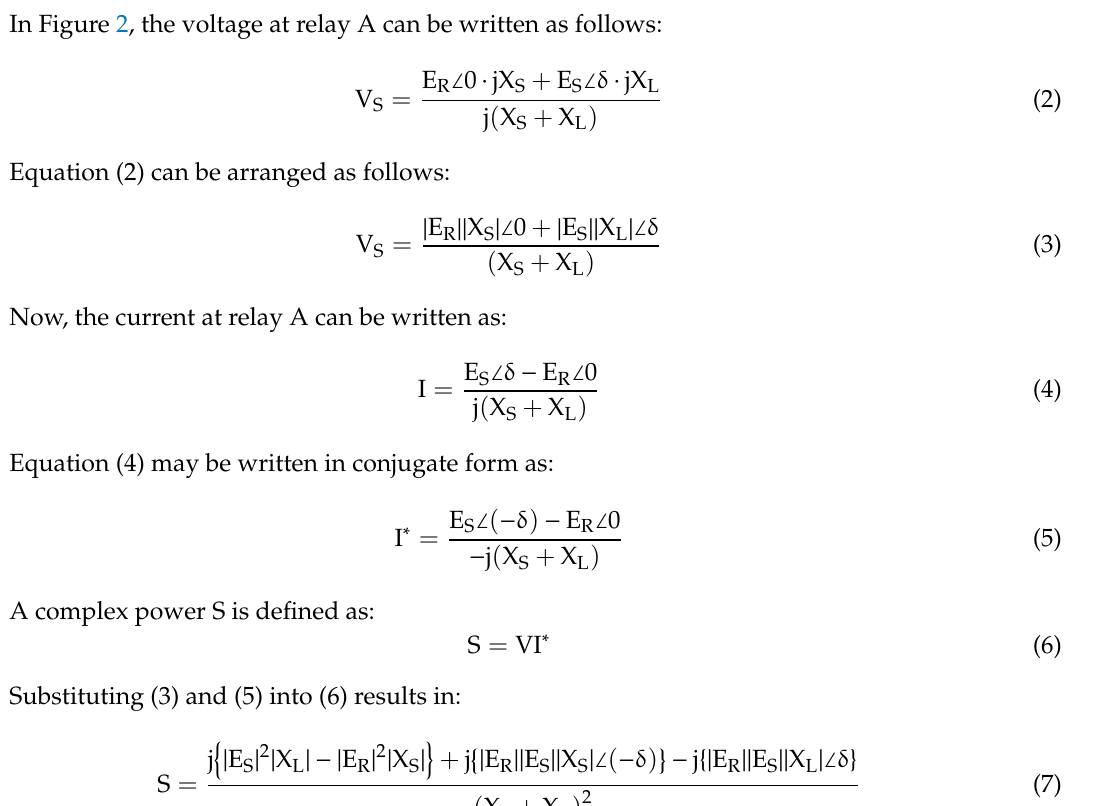
Figure 2. One machine infinite bus (OMIB) system.